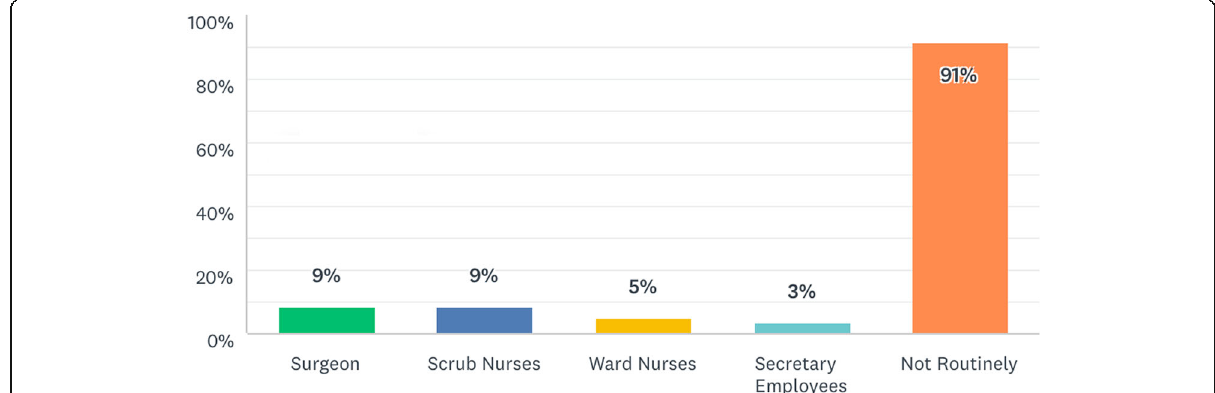
Fig. 3 Percentage of COVID-19 testing (PCR or immune testing) among health care personal at the time of resuming elective orthopaedic care